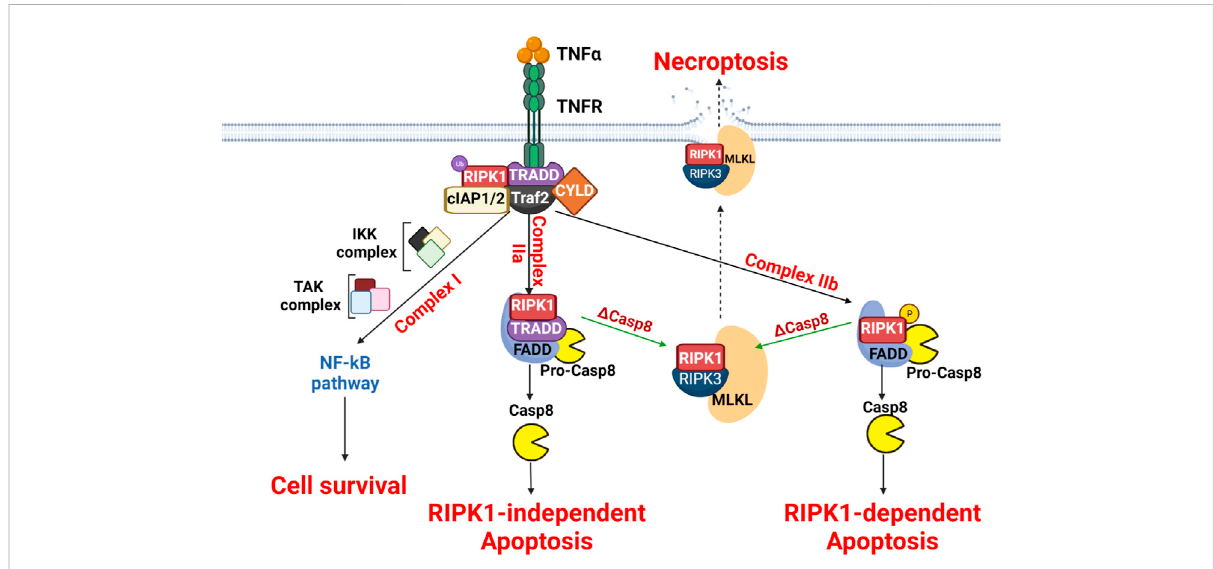
FIGURE 3 Molecular mechanisms of necroptosis. The scheme presents the three signaling pathways downstream of TNFR involving complex I, complex IIa and complex IIb formation. These complexes in fl uence differentially cell fate. In the absence of caspase 8, necroptosis is then